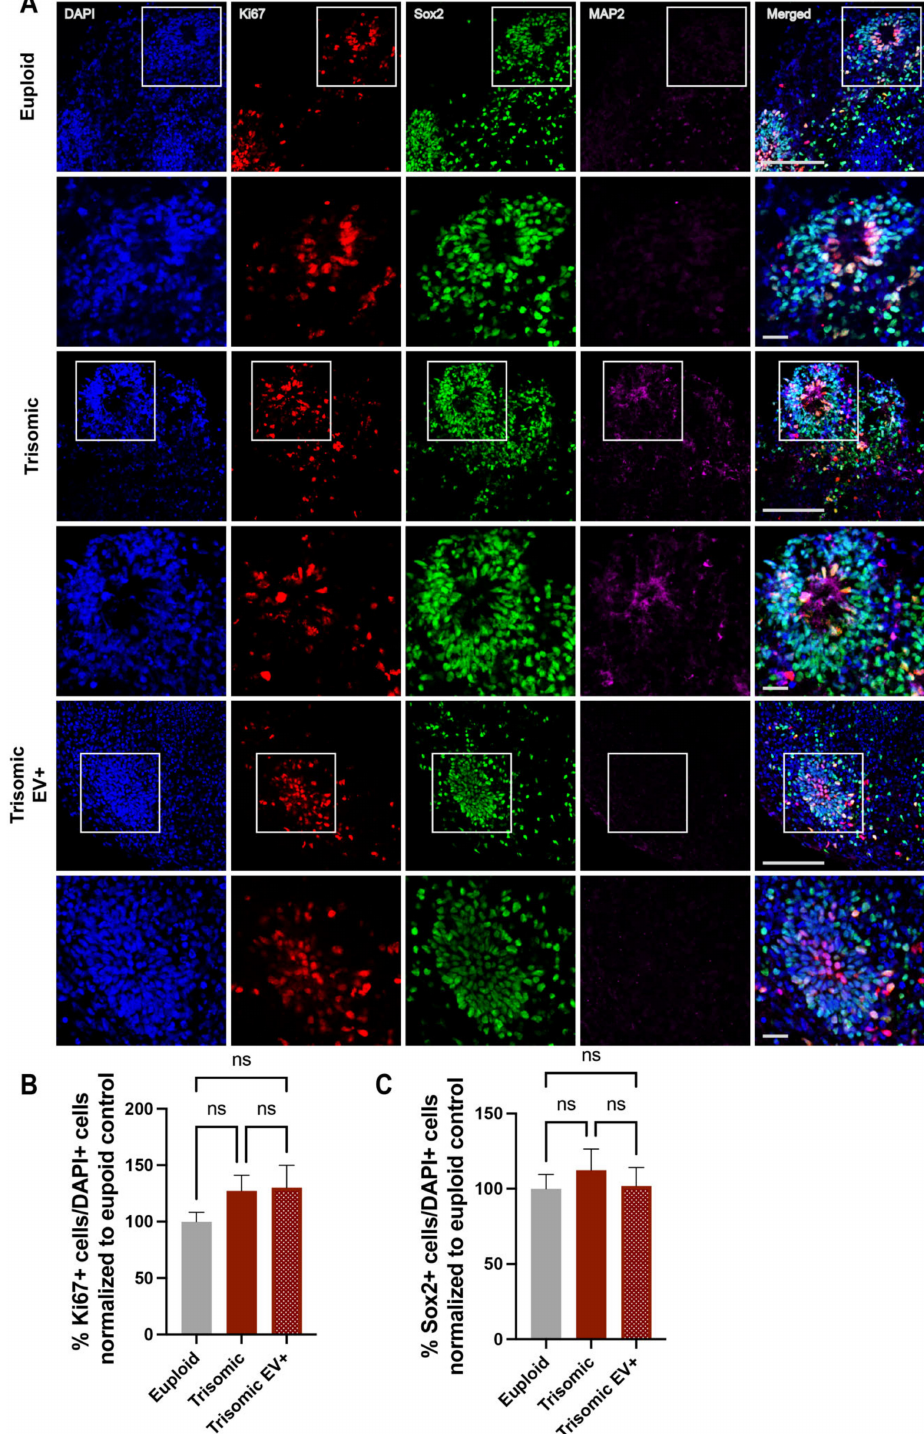
Figure 2. Measurements of proliferative markers in CS are unaffected by EV treatment. ( A ) Single and merged channels of confocal images showing DAPI staining (blue) with IHC labeling of MAP2 (magenta), SOX2 (green), and Ki67 (red) in euploid and trisomic untreated and EV-treated CS generated from isogenic cell lines showing VZ-like structures. The top panels show low magnification images, scale bar = 100 µ m. White boxes represent high magnification insets seen in the bottom panels, scale bar = 20 µ m. ( B , C ) Bar graphs showing quantification of the percentages of SOX2+